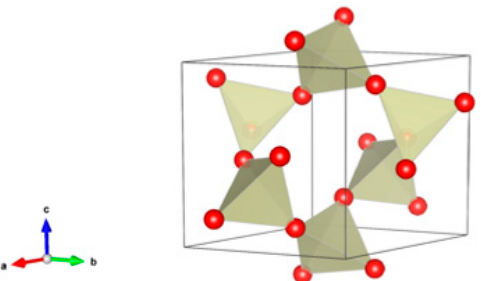
Figure 1. Silica, SiO 2 . α -quartz (low temperature modification), structure rhombohedra, Sp.